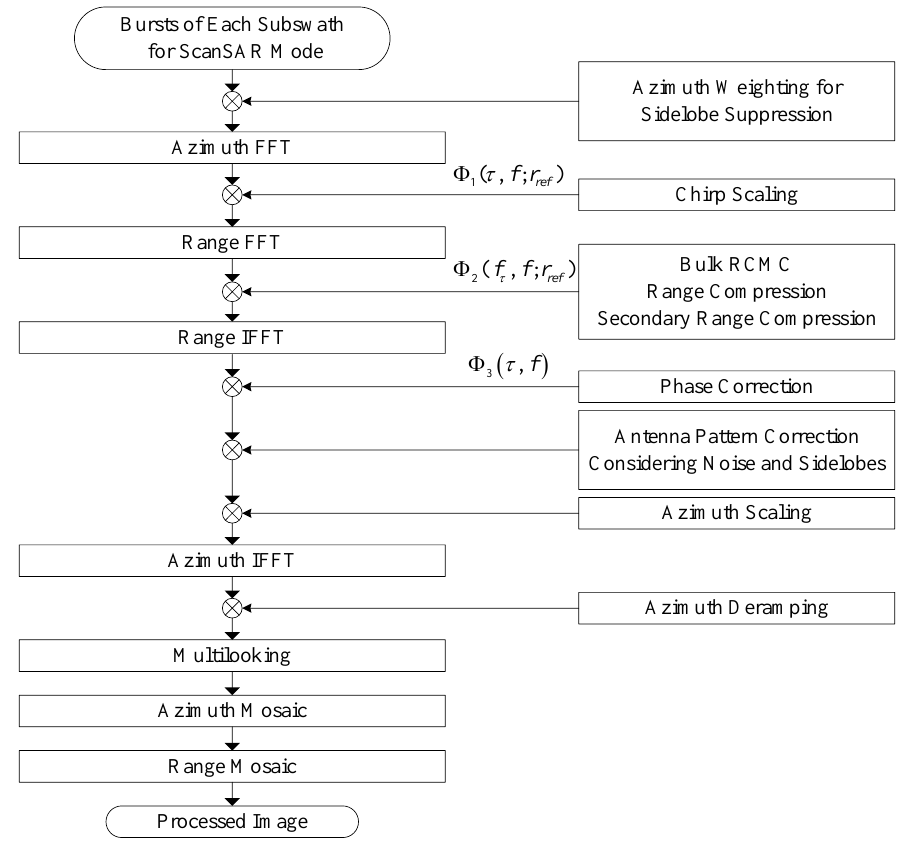
Figure 5. Block diagram of extended chirp scaling (ECS) algorithm for GF-3 scanSAR mode.